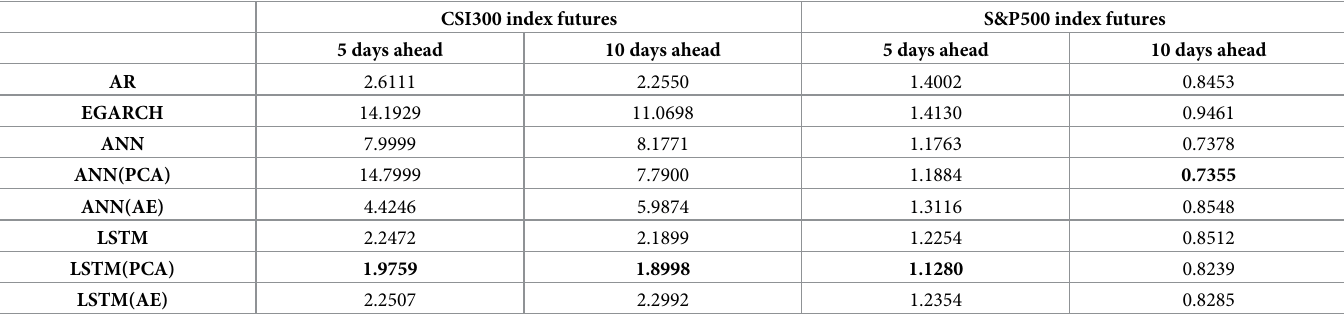
Table 3. Prediction performances in terms of MSE on testing